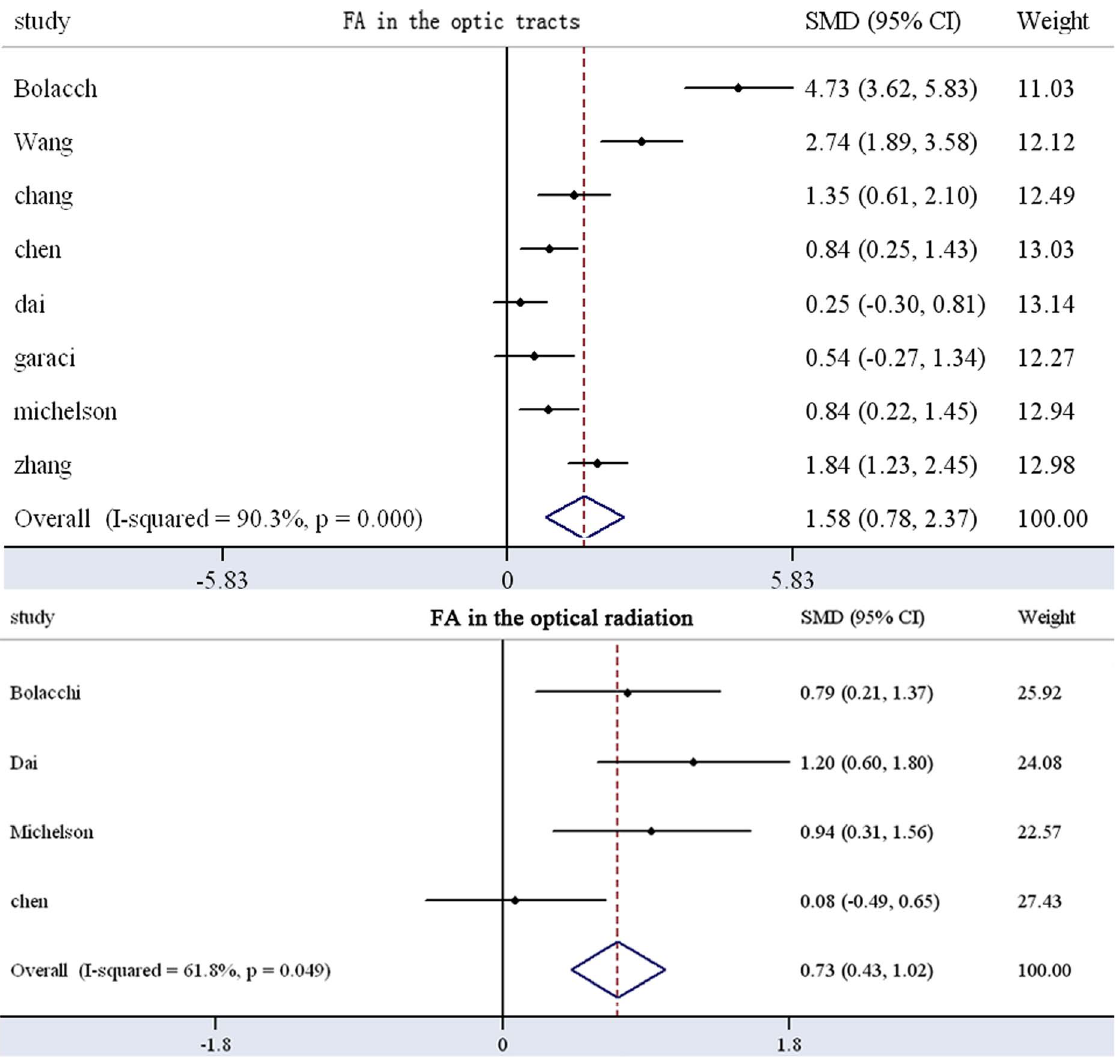
Figure 4. Meta-analysis results of MD in the optic tracts and optic radiation of patients with glaucoma compared with controls (data from Table 3). A significant difference between patients and controls was revealed, with high heterogeneity (P , 0.05 and the diamond shape appears on the right side; I 2 . 50%). MD: mean diffusivity; SMD: standardized mean difference; CI: confidence interval.